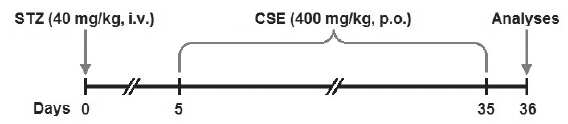
FIGURE 1 - Experimental design.